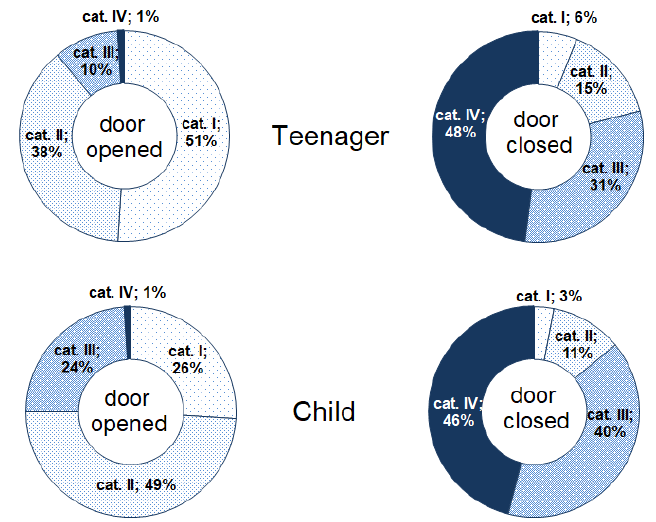
Figure 4. Categories of the indoor environment inside the teenager’s and child’s bedrooms during the night.